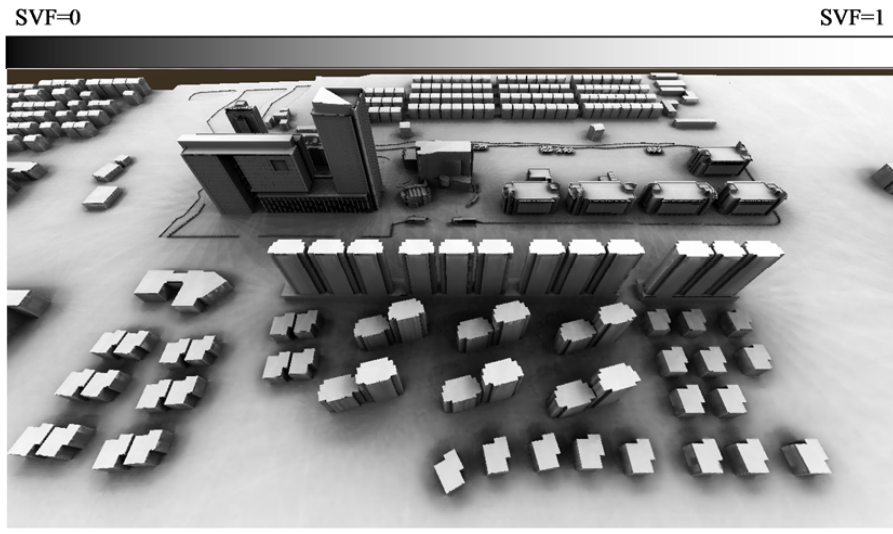
Figure 12. Two highly detailed 3D building models in the high-tech park.